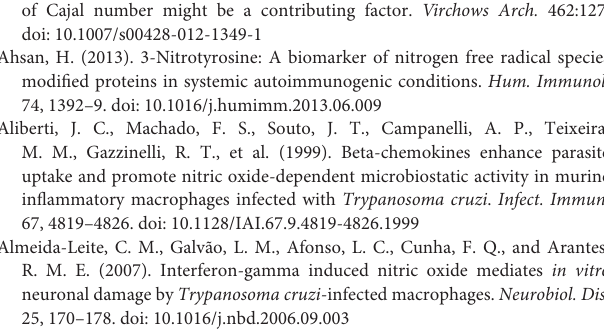
Supplementary Figure 1 | Histopathological aspects of the colonic changes induced by the infection with the Y strain of T. cruzi . (A) CD4 + and (B) CD8 + cells observed in muscularis propria of chronic infected animals (15m.p.i.) were quantified and expressed as (C) percentage of imunophenotyped (CD4 + and CD8 + ) cells/total cells of control and infected mice at acute (IAP, 11 d.p.i.) and chronic phase (ICP15, 15m.p.i.). The percentage of CD4 + cells / total cells was higher for the infected groups when compared to the control groups (CTRL). The percentage of CD8 + cells / total cells decreased in IAP when compared to CTRL (CAP) animals, but increased in ICP15 mice ( P = 0.07); (D–H) Histopathological aspects observed in colon samples of infected animals stained with HE where (D) CAP, (E) IAP, (F) ICP3, (G) ICP7, (H) ICP12, and (I) ICP15. Inflammatory foci were found scattered throughout the colon wall, at all times of the experiment. Notice that inflammatory cells in (E) (IAP) and (F) (ICP3) are associated with the vacuolization of parenchyma cells and hyper-eosinophilia. The infiltrate surrounds the enteric ganglia and sometimes blur its limits (inset, dashed line). Arrowhead indicates inflammatory infiltrate. (J) CTRL, (K) IAP, (L) ICP3, (M) ICP7, (N) ICP12, and (O) ICP15 Masson’s trichome stains the connective tissue in blue. Reorganization and increased production of collagen fibbers throughout the infection. Thin arrows indicate interstitial and periganglionic collagen fibers, large arrows indicate collagen fibbers in the submucosal plexus. Scale Bar: 3 µ m.